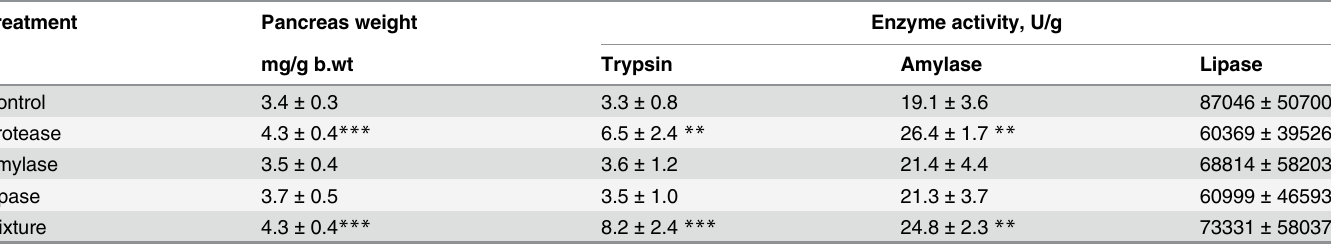
Table 4. Pancreas weight and enzyme content of 17 d-old rats after gavage feeding with microbial-derived enzymes, i . e ., a protease, amylase, lipase, and a mixture thereof, or water (control) during 14 – 16 days of age.